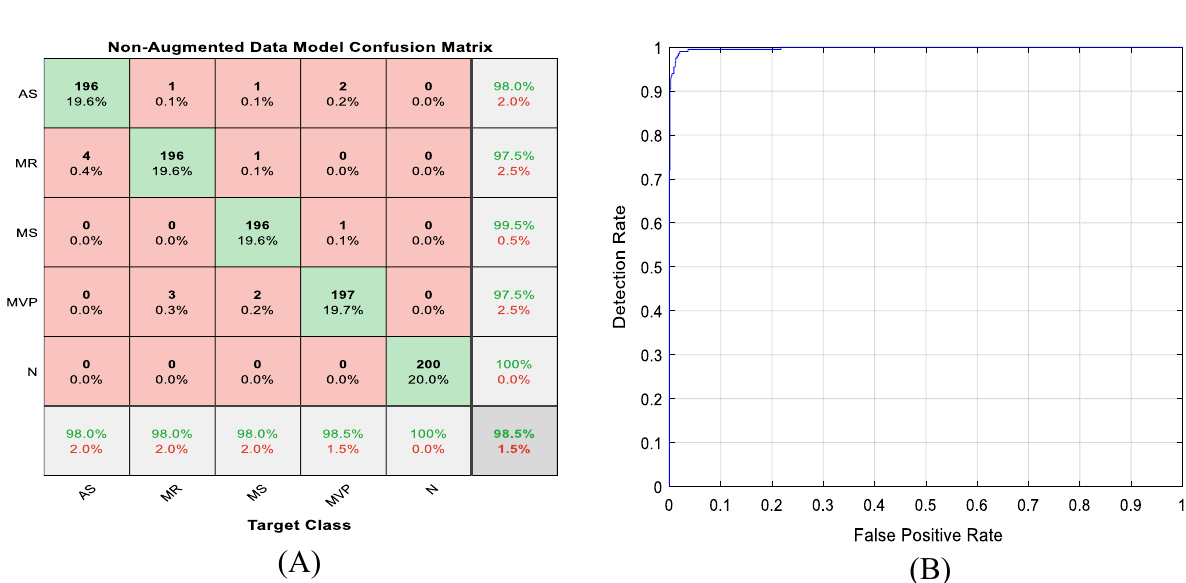
Figure 12. ( A ) Non-augmented data model confusion matrix. ( B ) Receiver operating characteristic (ROC)